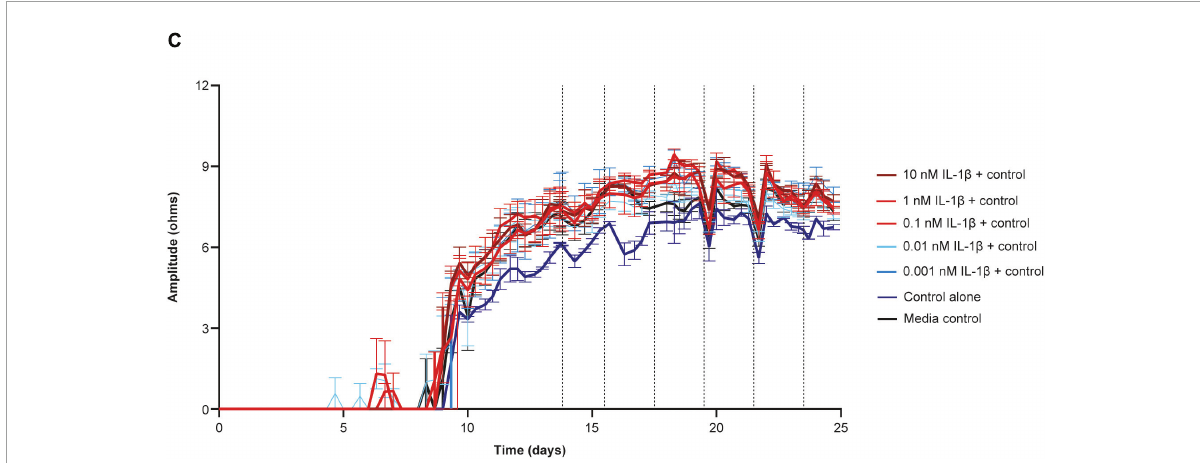
FIGURE4 IL-1 β induces Activin A gene expression in cardiac fibroblasts. (A) The effect of inflammatory cytokines, IL-1 β , IL-6, and oncostatin M on gene expression in cardiac fibroblasts. (B) The concentration of Activin A in control- and IL-1 β -treated cells. (C) The effect of IL-1 β on induced pluripotent stem cell-derived CM contractility (vertical lines indicate media changes). One-way ANOVA was used to determine significance. **** P < 0.0001. ActA, Activin A; CM,